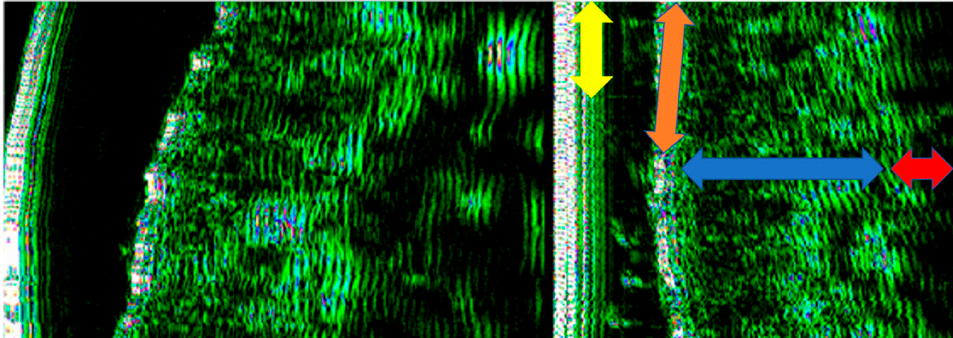
Figure 2. HFU (DUB cutis, Taberna Pro Medicum, Lüneburg, Germany) 22 MHz zygomatic skin evaluation. The images are exported in pixels in order to evidence tissue density (white and blue—very dense, green—dense, and black—low density). Yellow arrow—probe membrane and applied gel, red arrow—hyperpixeled epidermis; blue arrow—pixeled dermis, red arrow—low-density hypodermis .